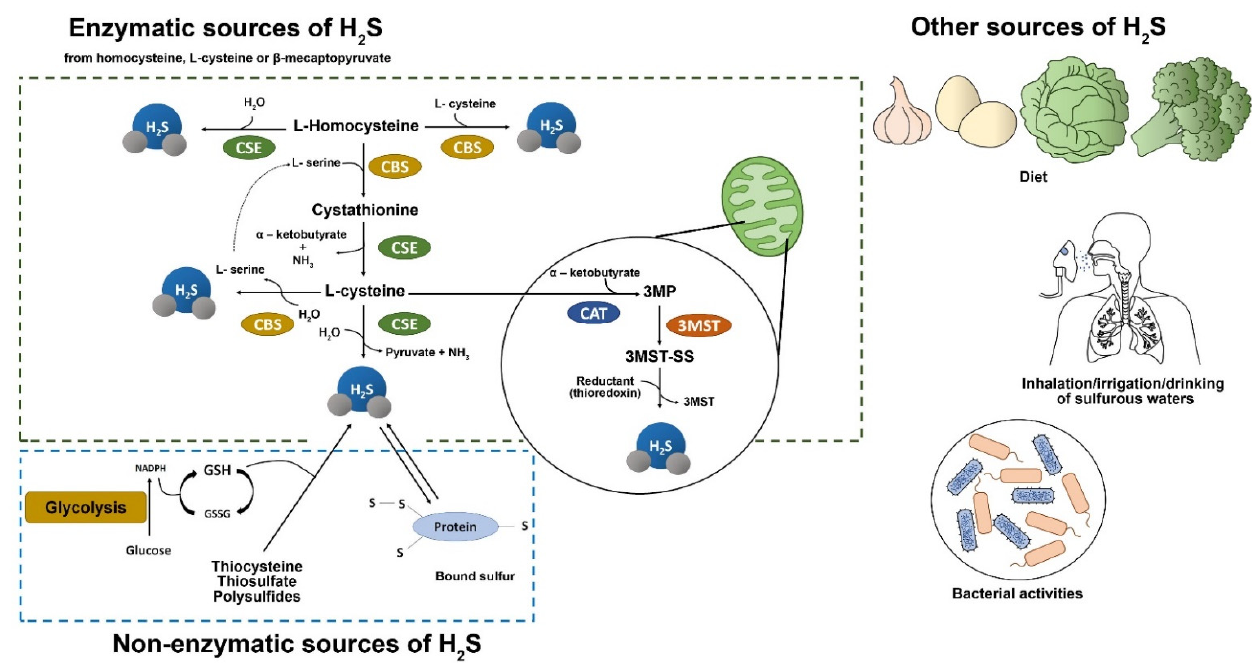
Figure 2. Source of H 2 S. There are four enzymatic pathways (dotted green rectangle) for the biosyn- thesis of H 2 S, including CBS, CSE, 3MST coupled with CAT, and 3MST that utilize L-cysteine, L- Homocysteine, and 3-mercaptopyruvate (3MP) as substrates. CBS and CSE may generate H 2 S in the cytosol whereas 3MST mainly resides and synthesizes H 2 S in mitochondria. A small portion of en- dogenous H 2 S is derived via nonenzymatic reduction (dotted blue rectangle). In the presence of reducing equivalents such as NADPH and NADH, reactive sulfur species in persulfides, thiosulfate, and polysulfides are reduced into H 2 S and other metabolites. Other sources of H2S are represented by diet, bacterial activities, inhalation, irrigation, and drinking of sulfurous waters. 3MP, 3-mercap- topyruvate; 3MST, 3-mercaptopyruvate sulfurtransferase; CAT, cysteine aminotransferase; CBS, cystathionine β -synthase; CSE, cystathionine γ -lyase; H 2 S, hydrogen sulfide; NADH, nicotinamide adenine dinucleotide; NADPH, nicotinamide adenine dinucleotide phosphate.